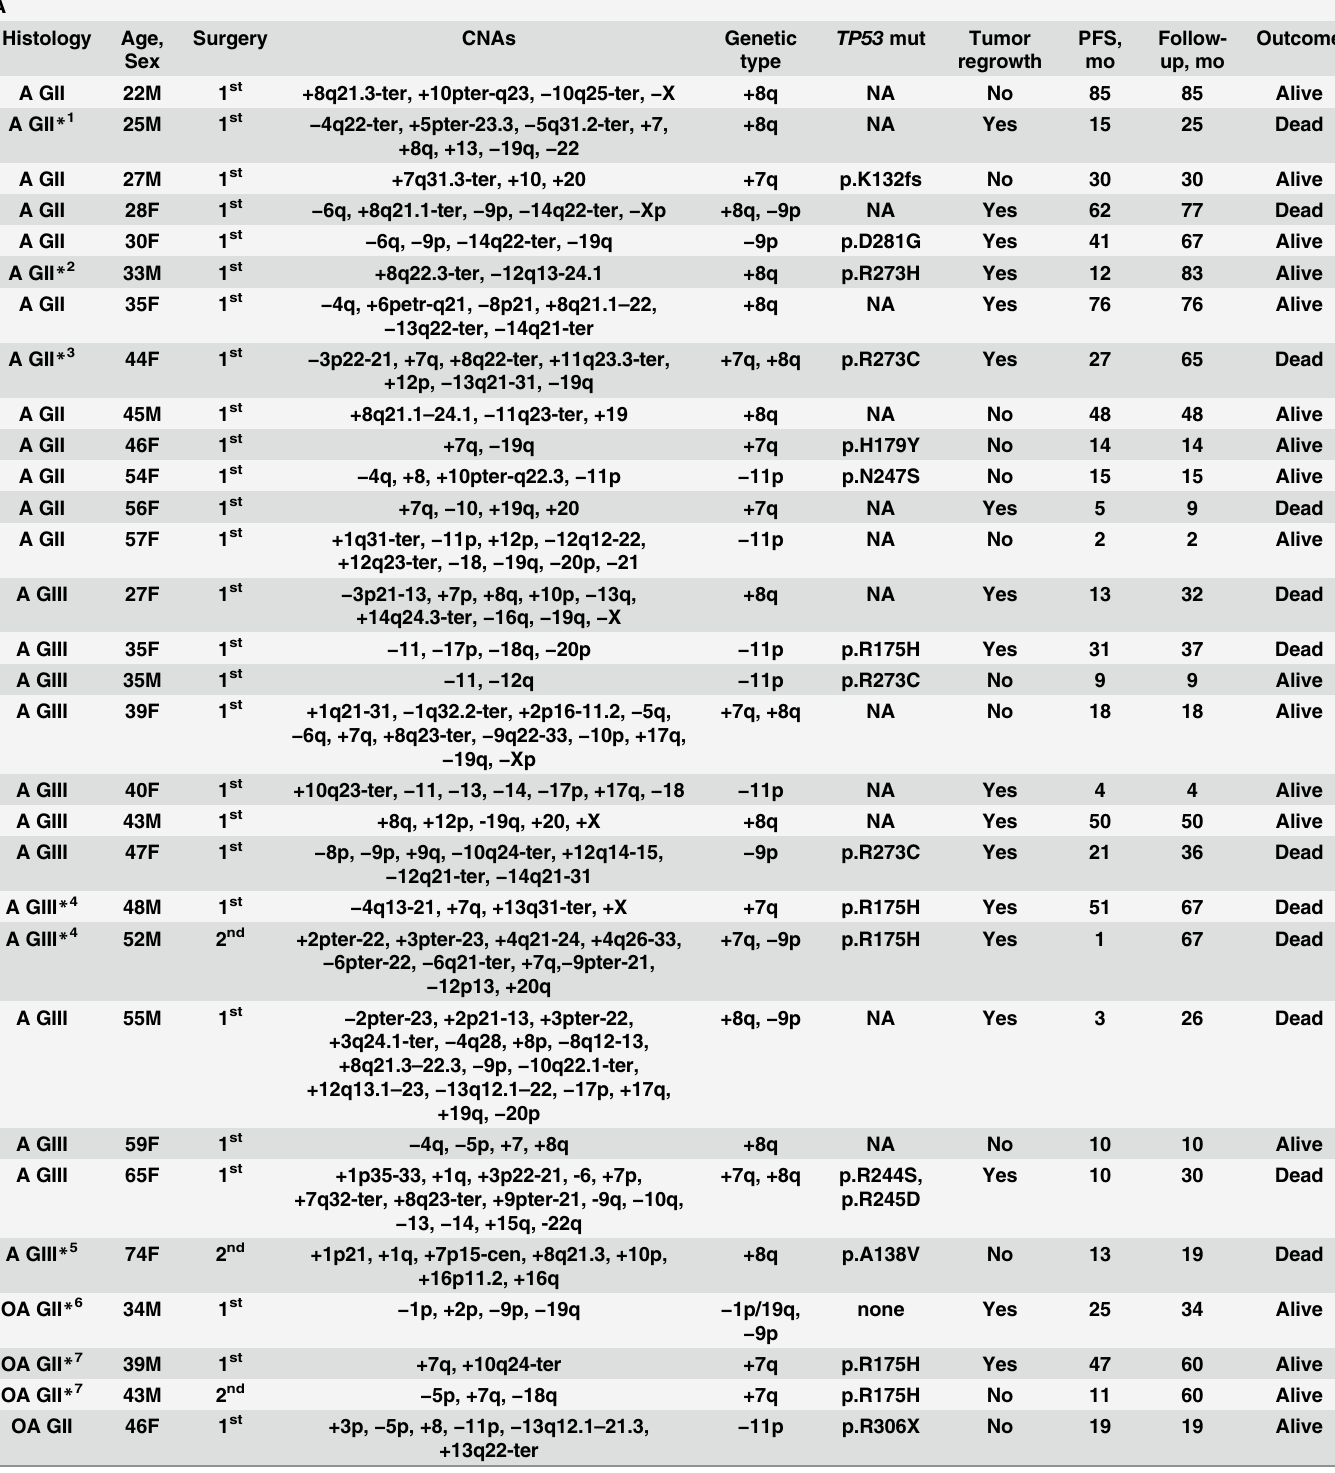
Table 2. A list of IDH mutant glioma patients with (A) and without (B) +7q, +8q, − 9p, and/or − 11p according to comparative genomic hybridization (CGH) analysis as well as their prognosis and TP53 mutation